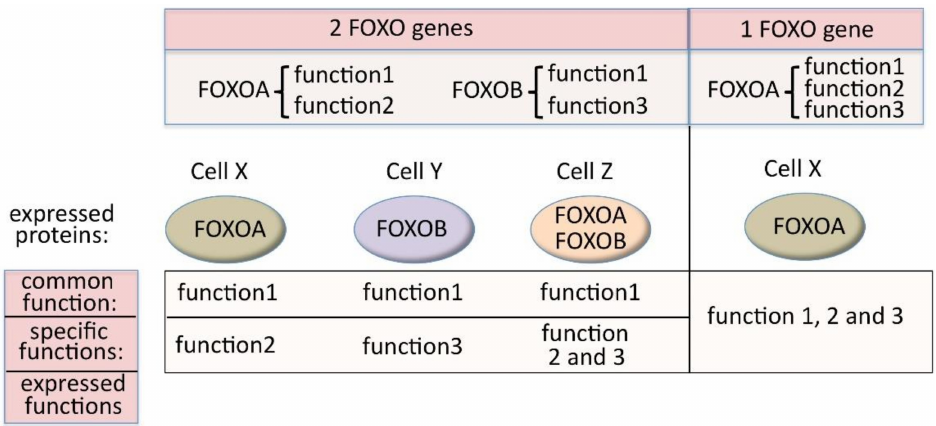
Figure 4. Possibility to express common functions in all cell types and specific functions in diverse cell types (left side) that would not be possible with the existence of a single FOXO gene (right